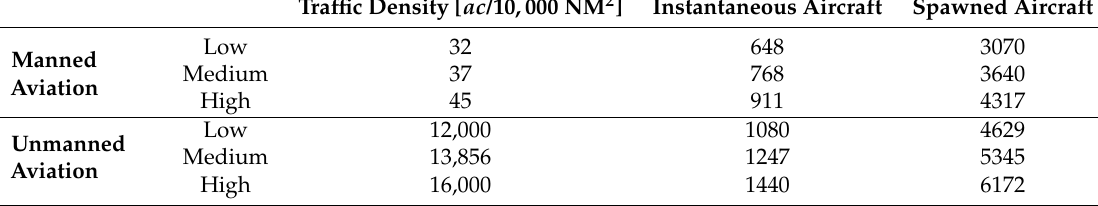
Table 7. Traffic volumes used in